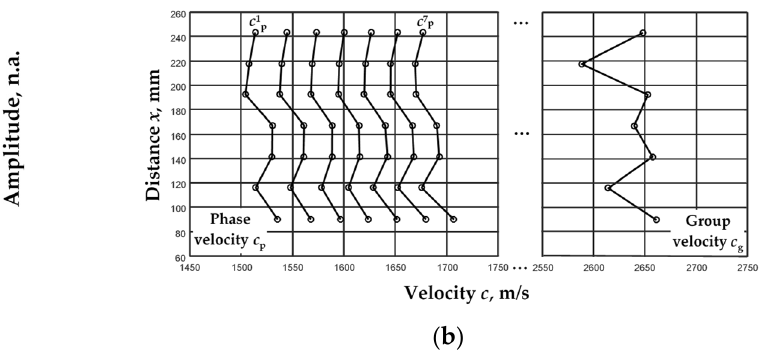
Figure 10. Lamb wave A 0 mode B-scan image (color-coded) with calculated zero-crossing instances (line) ( a ) and values of phase and group velocities calculated for the proposed algorithm (dots) ( b ). The results of the calculations are presented in Figure 10b (dots), where different ranges of phase and group velocity changes are shown separately. Seven phase velocity curves (both filters are used) and one group velocity curve were formed. After calculating the averages of the phase and group velocity changes, the mean absolute errors ∆ (cid:2926)((cid:2917))(cid:3036) and the mean relative errors 𝛿 (cid:2926)((cid:2917))(cid:3036) of the following velocities from the average were estimated for each filter separately: